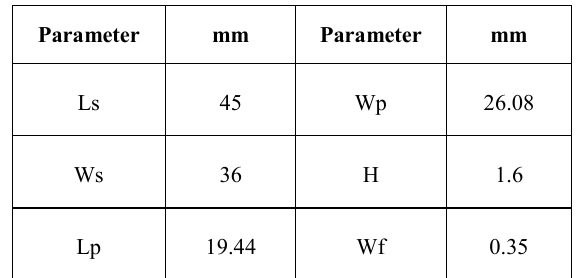
Table 2: The optimized parameters of the conventional patch